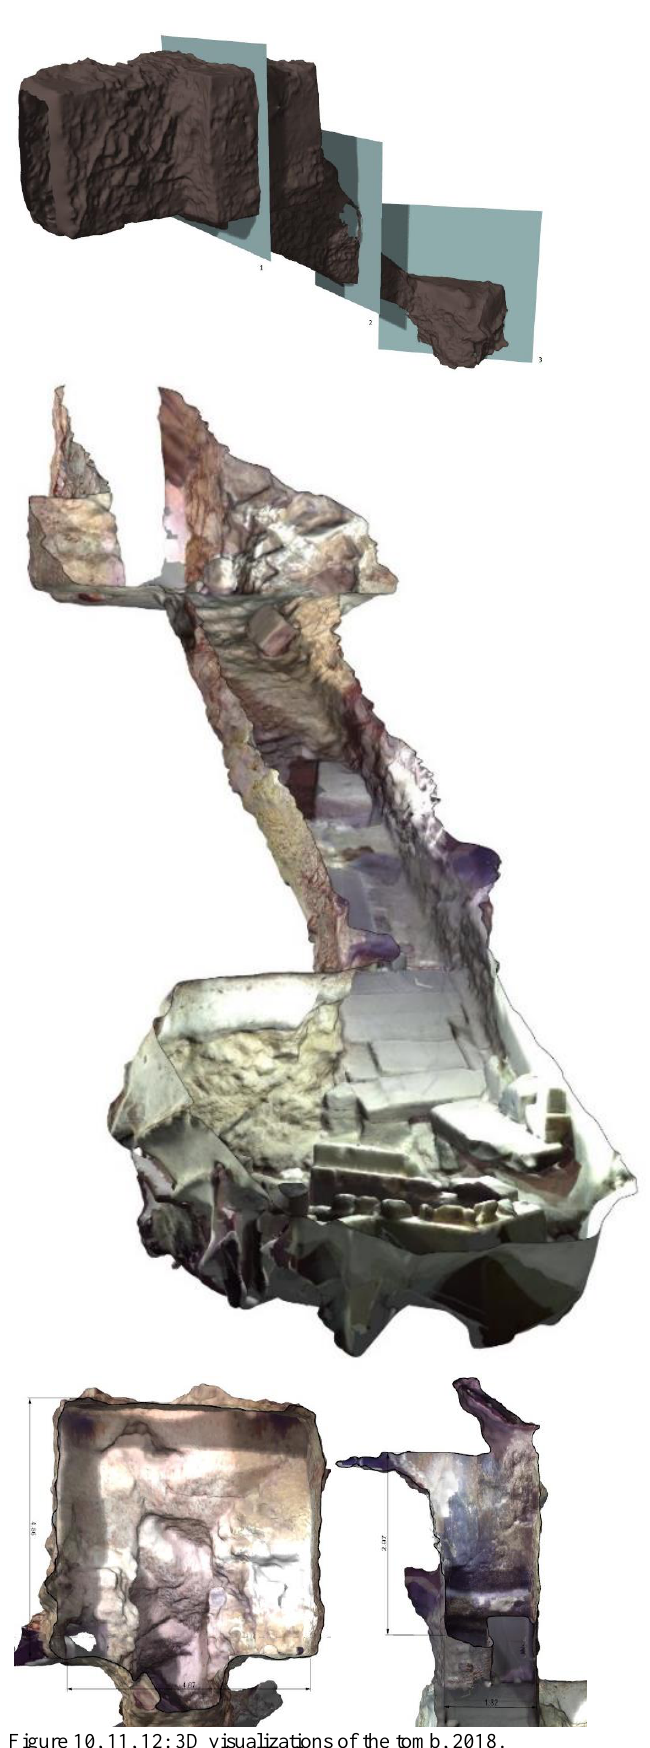
Figure 10, 11, 12: 3D visualizations of the tomb,